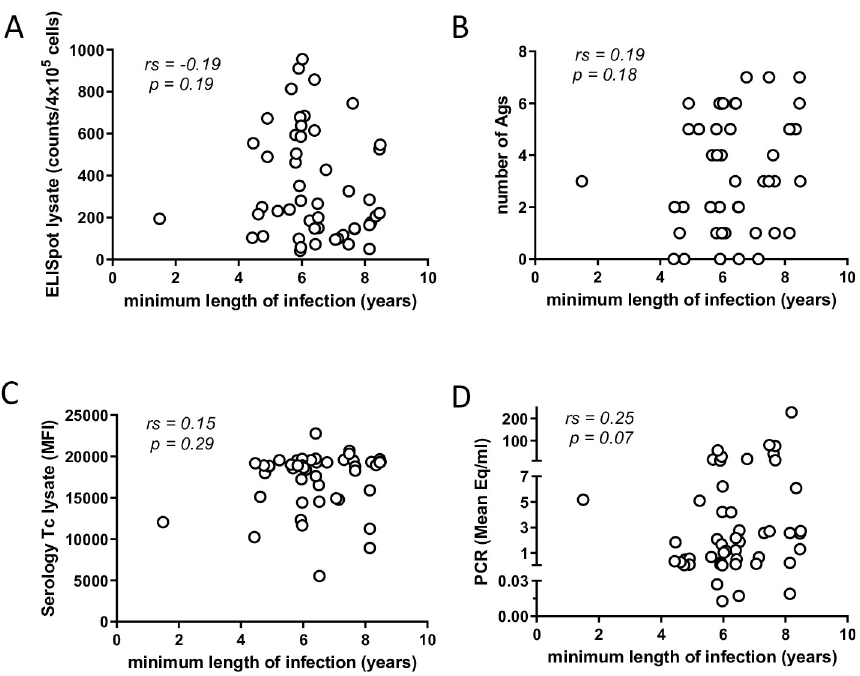
Fig 4. Minimum length of infection in macaques does not modify immunological and parasitological parameters. Cellular (A) and humoral (C) responses against T . cruzi lysate for macaques displaying diverse minimum lengths of infection. (B) Number of recombinant T . cruzi antigens recognized by macaques infected for different periods of time measured by multiplex assay. (D) Parasite load in macaque blood determined by serial qPCR. (n = 50).